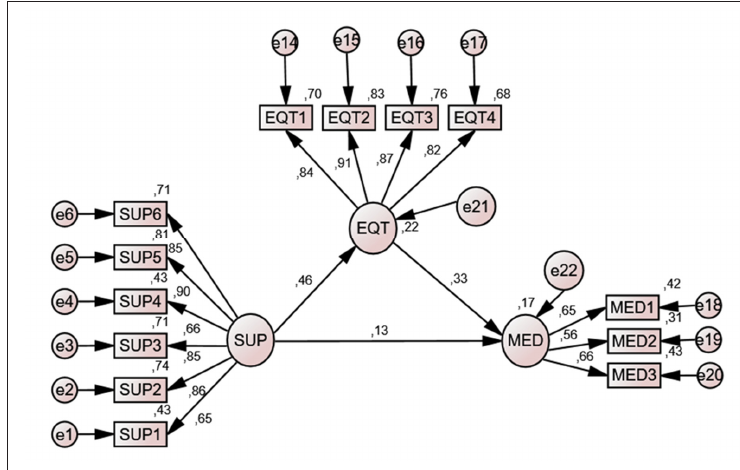
Figure 1. Proposed structural model